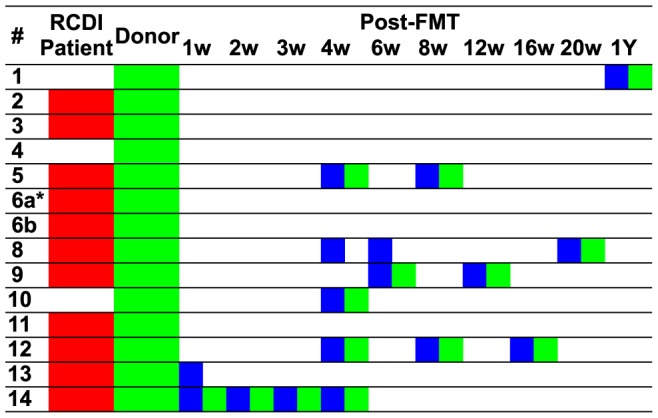
Overview of analyzed patient and donor samples.RCDI patient samples are marked in red, post-FMT patient samples in blue and donor samples in green. *Patient #6a experienced antibiotic-induced relapse of C. difficile infection and was treated successfully with a second round of FMT as patient #6b. In the NCBI short read archive, samples referred to as #6b are designated as #7 samples.